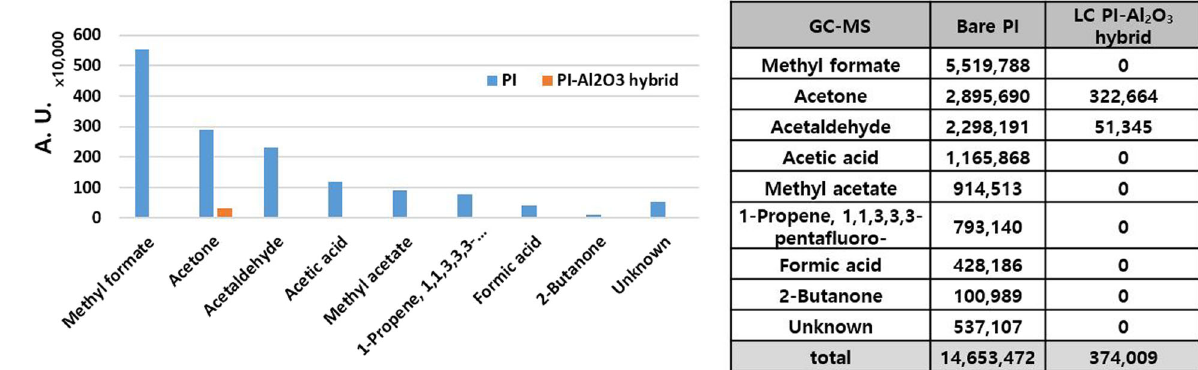
Fig. 3 The results of GC-MS. Out-gassing results using GC – MS measurements for the bare PI layer and the PI-Al 2 O 3 hybrid nanolayer after the UV radiation test.